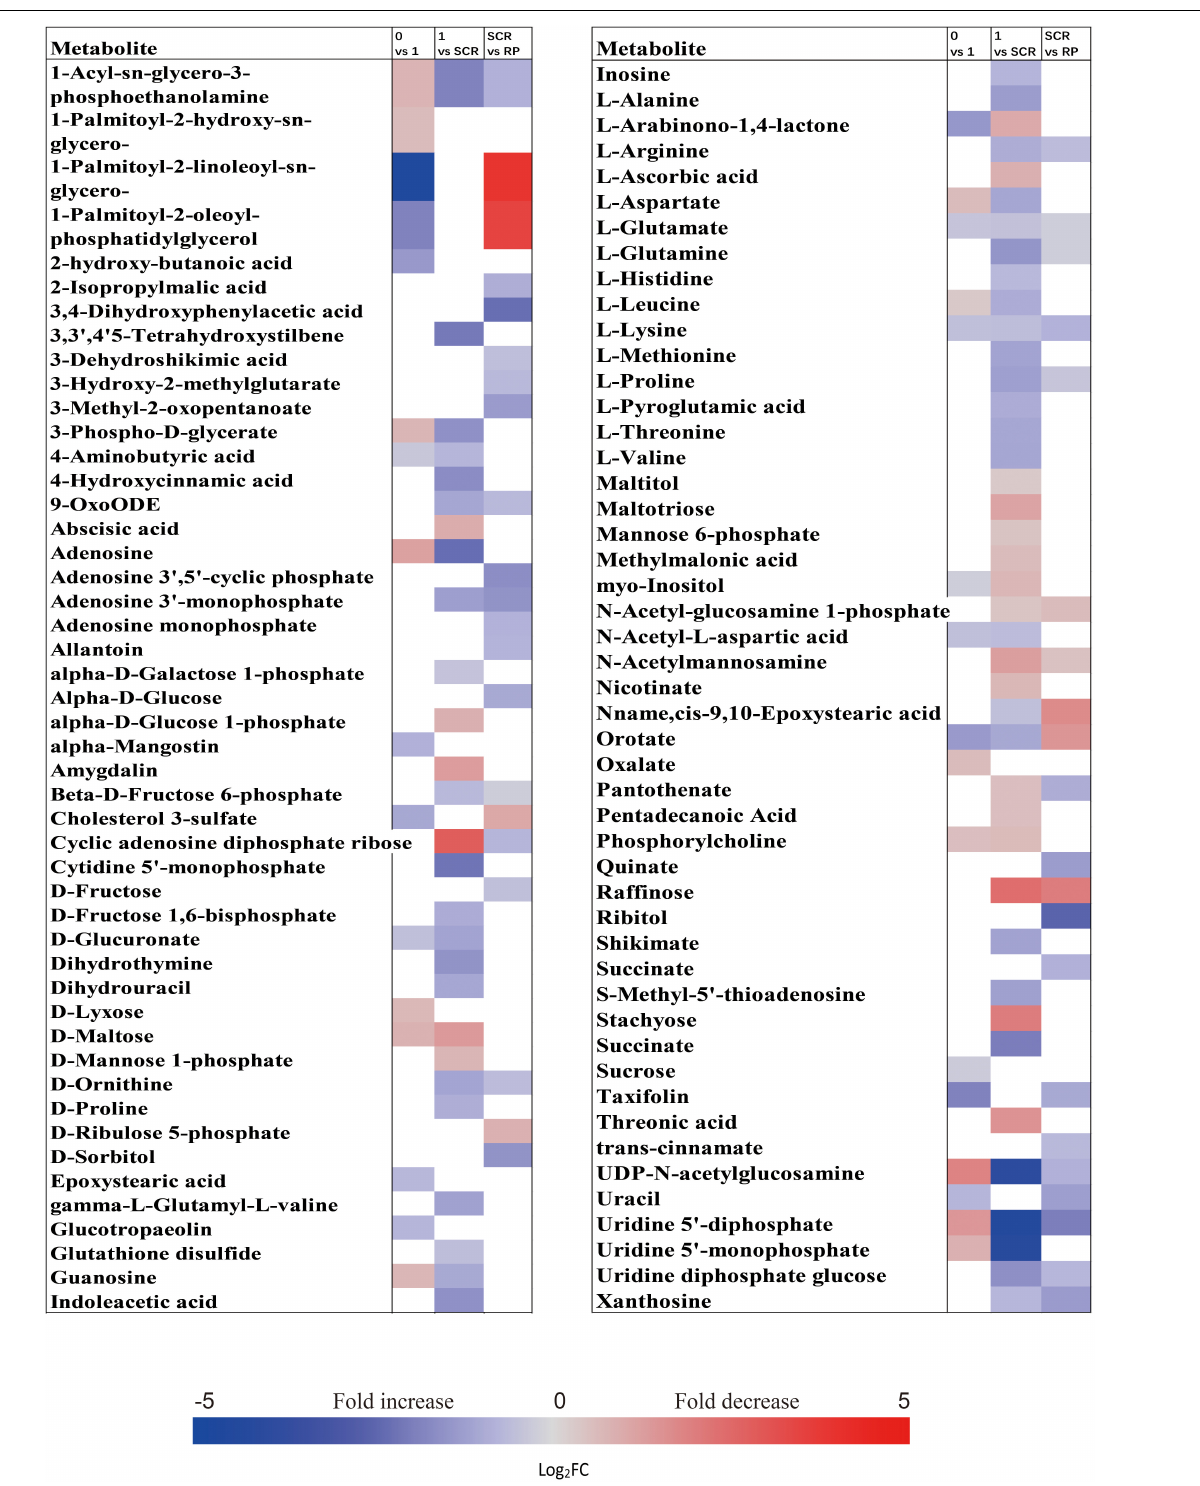
FIGURE 6 | Fold change in the relative contents of important metabolites with VIP value > 1 and P < 0.05 in the megagametophytes of non-primary physiological dormant seeds (NDS) between different incubation time points, such as 0 week vs. 1 week, 1 week vs. SCR (seed coat rupture), and SCR vs. RP (radicle protrusion). Fold changes are represented as a heat map. White coloring indicates no significant change. VIP, variable importance in the projection.